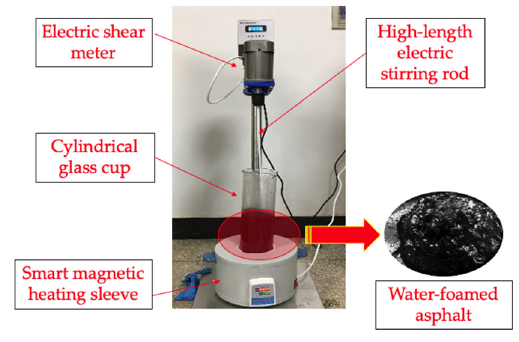
Figure 2. Self-designed laboratory foaming machine